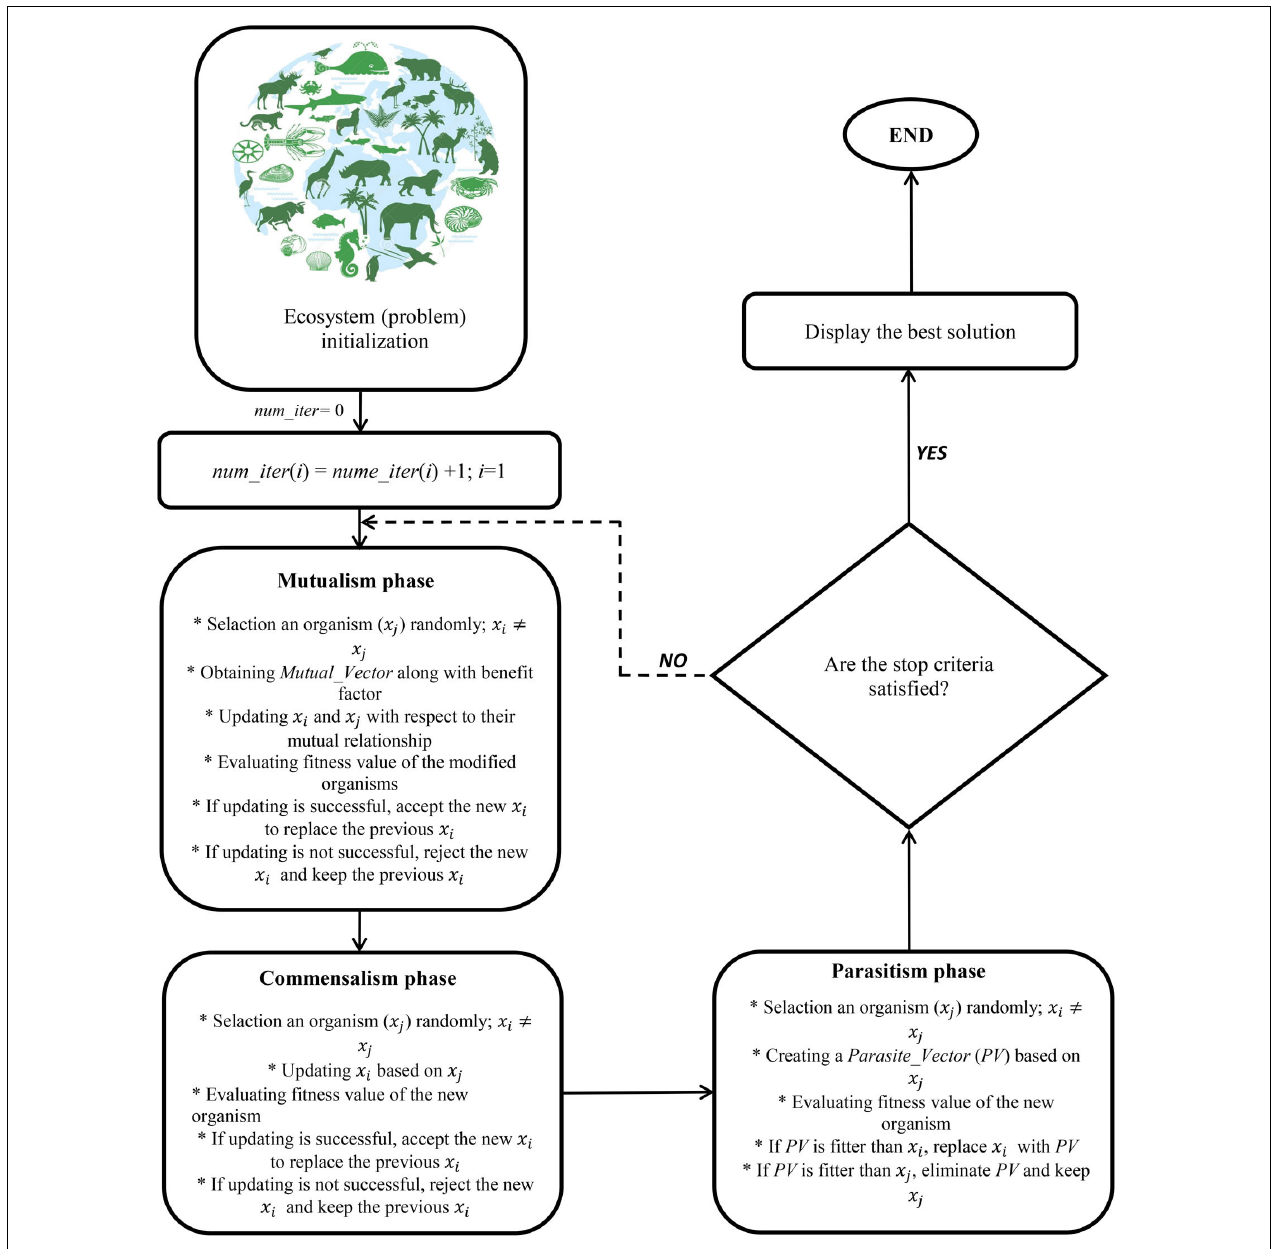
FIGURE 8 | A schematic representation of symbiotic organisms search (SOS)